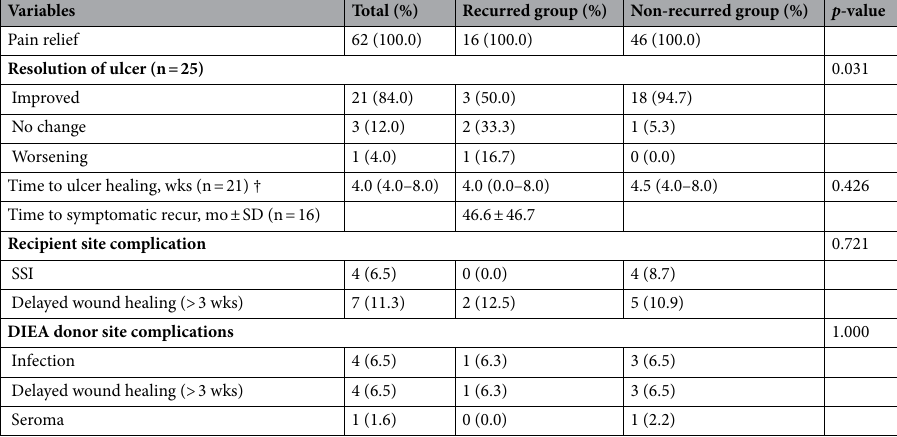
Table 3. Result-related Variables and Postoperative Complications in the Recurred and Non-recurred Groups. SSI, surgical site infection; DIEA, deep inferior epigastric artery. † Median (interquartile